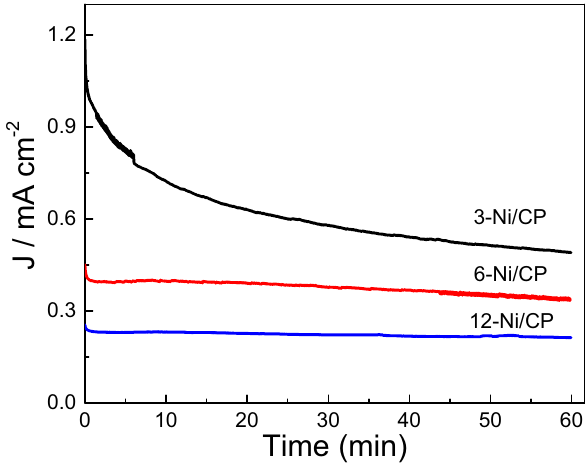
Fig. 8 Cyclic voltammograms of 3-Ni/CP, 6-Ni/CP and 12-Ni/CP electrocatalysts in 1 mol L −1 KOH + 0.33 mol L −1 urea. Scan rate of